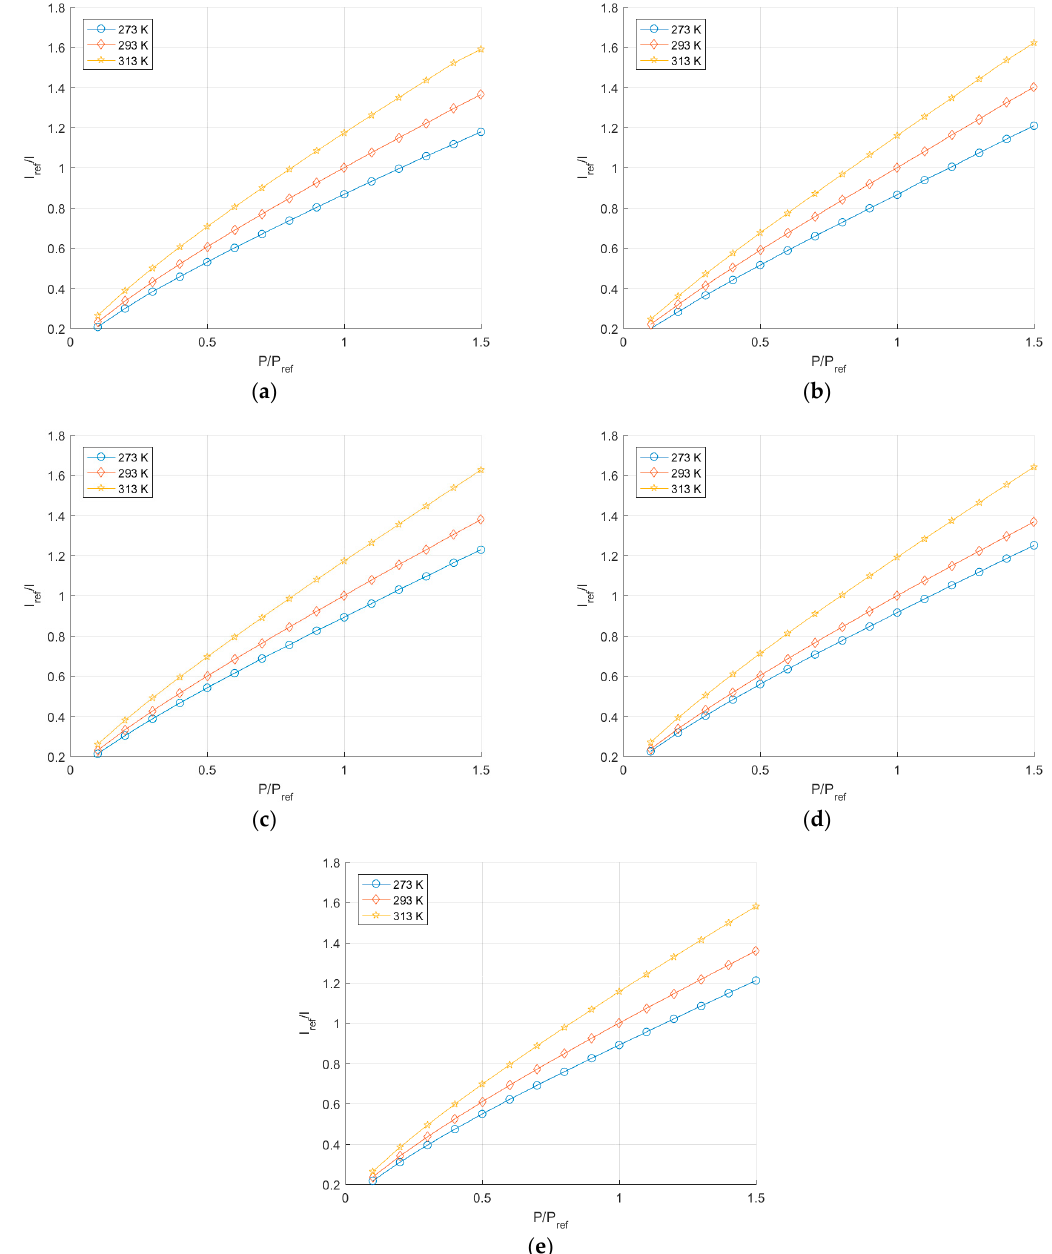
Figure 15. Stern-Volmer plot for ( a ) PCO.1600, ( b ) Basler Ace, ( c ) Basler Dart, ( d ) Genie Nano and ( e ) Ximea XiMU.